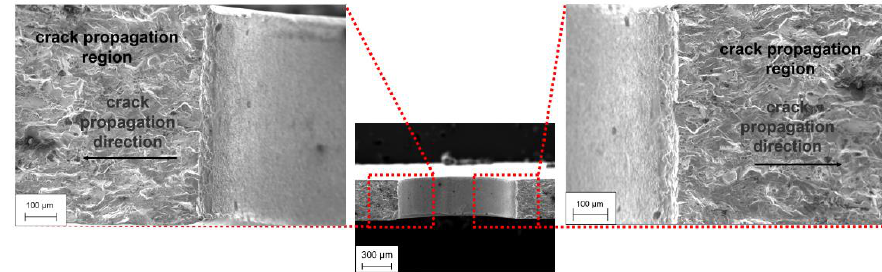
Figure 19. Overall morphology near circular notch.